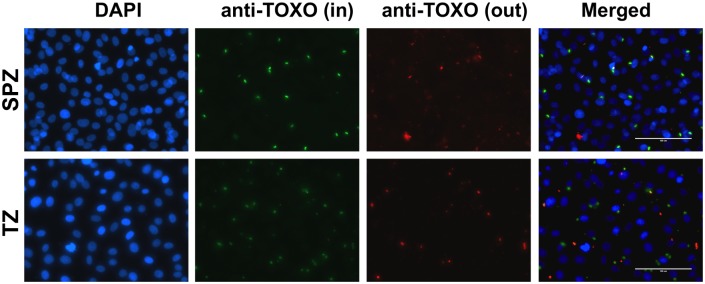
Quantification of infection in IEC-18 cells exposed to sporozoites or tachyzoites.Representative fluorescent microscopy images of confluent IEC-18 cells on glass coverslips infected with Toxoplasma type II M4 strain sporozoites and tachyzoites for 8 hours. Parasites were stained with either mouse or rabbit anti-Toxoplasma antibody before and after membrane-permeabilization to identify extracellular parasites (red) and intracellular parasites (green). DAPI was used to stain nuclear DNA. Images were obtained at 40X magnification. The scale bar is 100 μm.